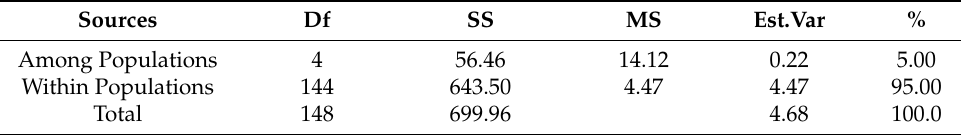
Table 5. Analysis of molecular variance (AMOVA) of the studied populations.